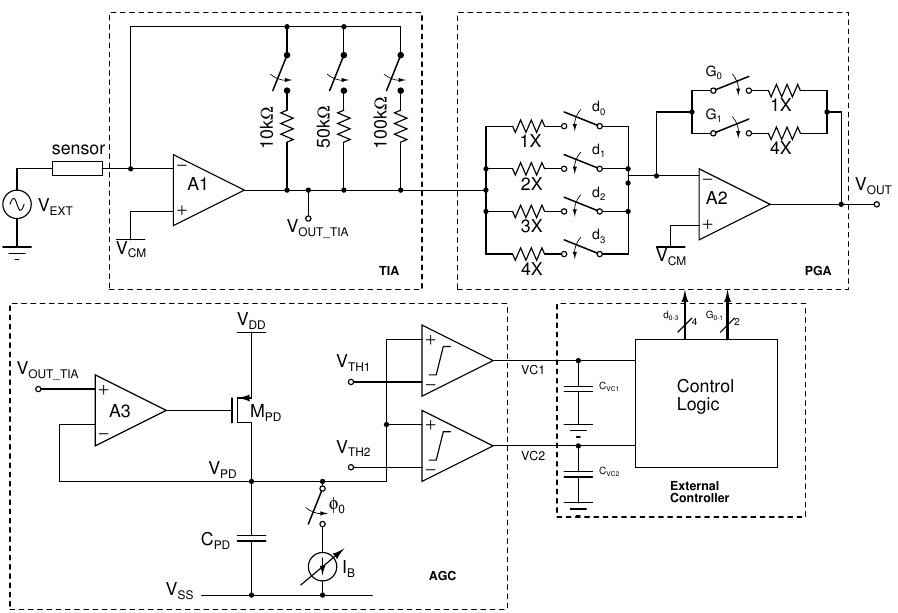
Figure 4. Architecture of the current-mode channel with automatic gain compensation.